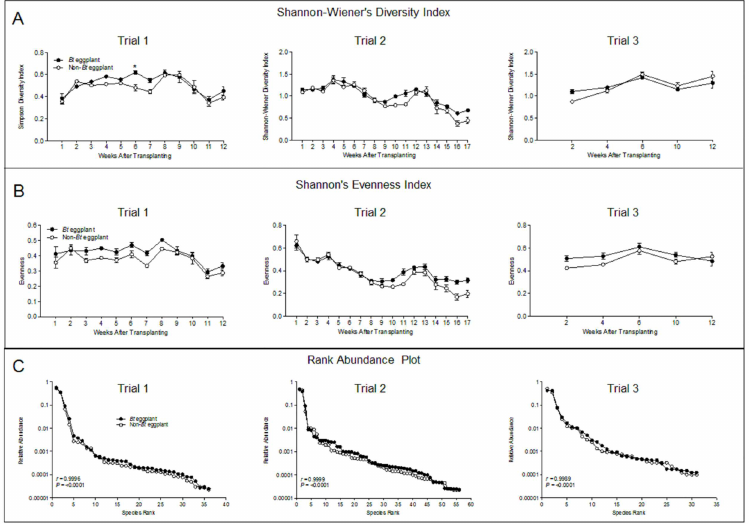
Fig 3. Other descriptors of non-target arthropod (NTA) communities in Bt and non-Bt eggplants. (A) Shannon’s diversity index and (B) Shannon’s evenness index; P value indicates significance between indices (not significant, P > 0.05). (B) Rank abundanceplots; Spearman rank correlation coefficient ( r ) indicatesa very strong positive correlationbetween Bt and non-Bt eggplants.Y axis is log 10